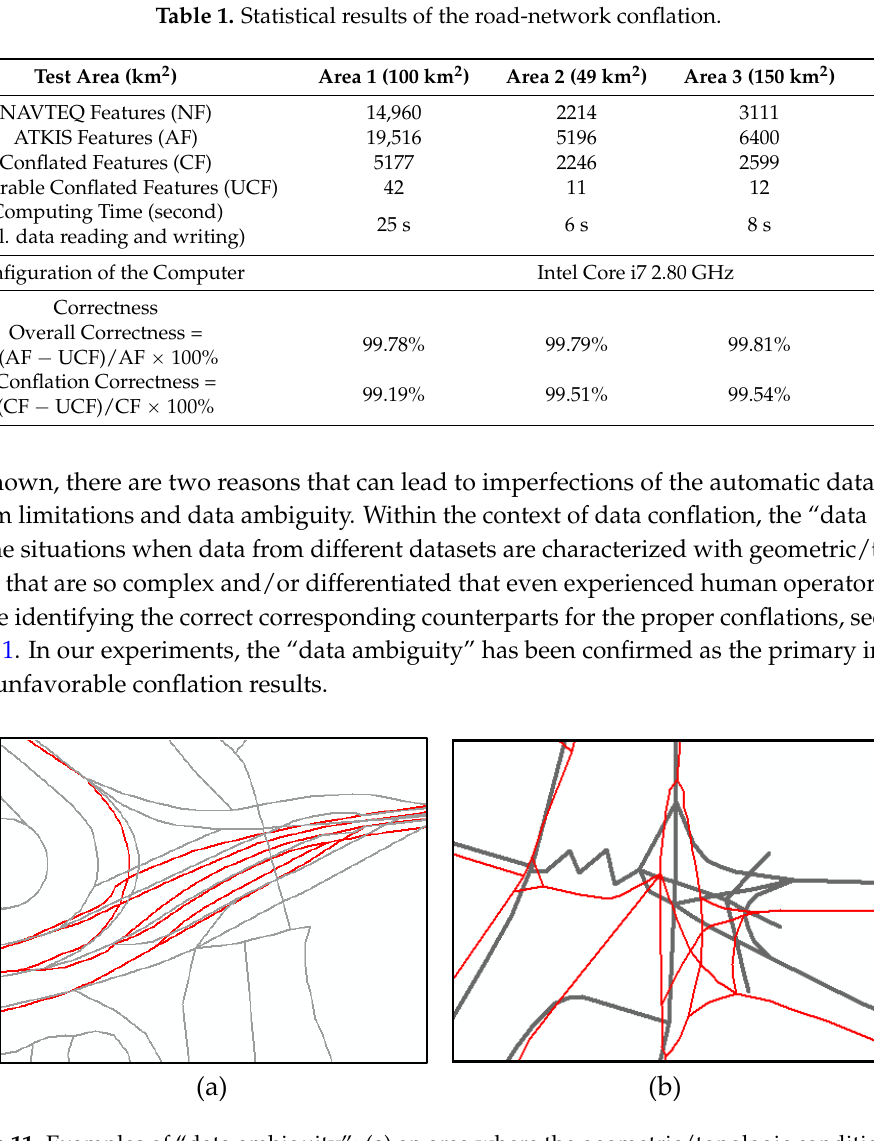
Figure 11. Examples of “data ambiguity”: ( a ) an area where the geometric/topologic conditions are very complex; ( b ) an area where the geometric/topologic conditions are distinct to each other. Red lines: NAVTEQ; grey lines: ATKIS.